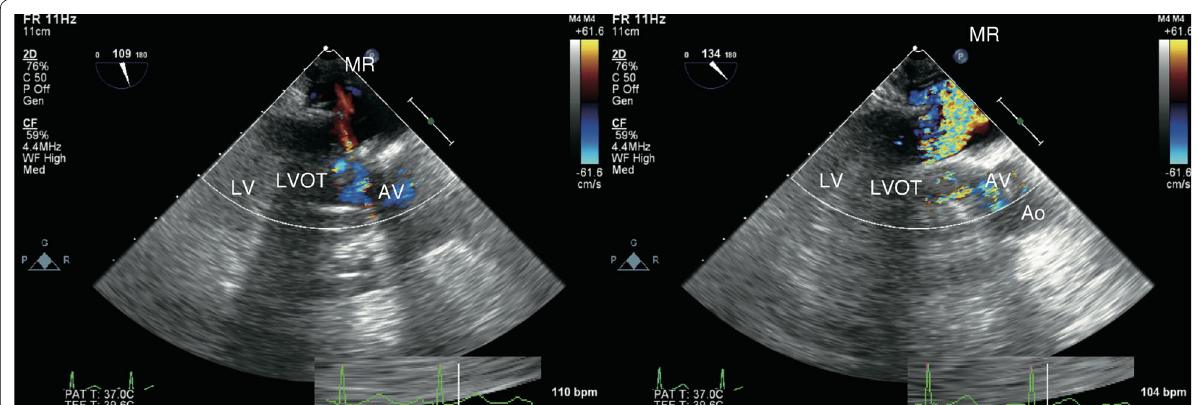
Fig. 2 Mitral regurgitation in normal sinus rhythm (left) and junctional rhythm (right). MR mitral regurgitation, LVOT left ventricular outflow tract, Ao ascending aorta, AV aortic valve, LV left ventricle